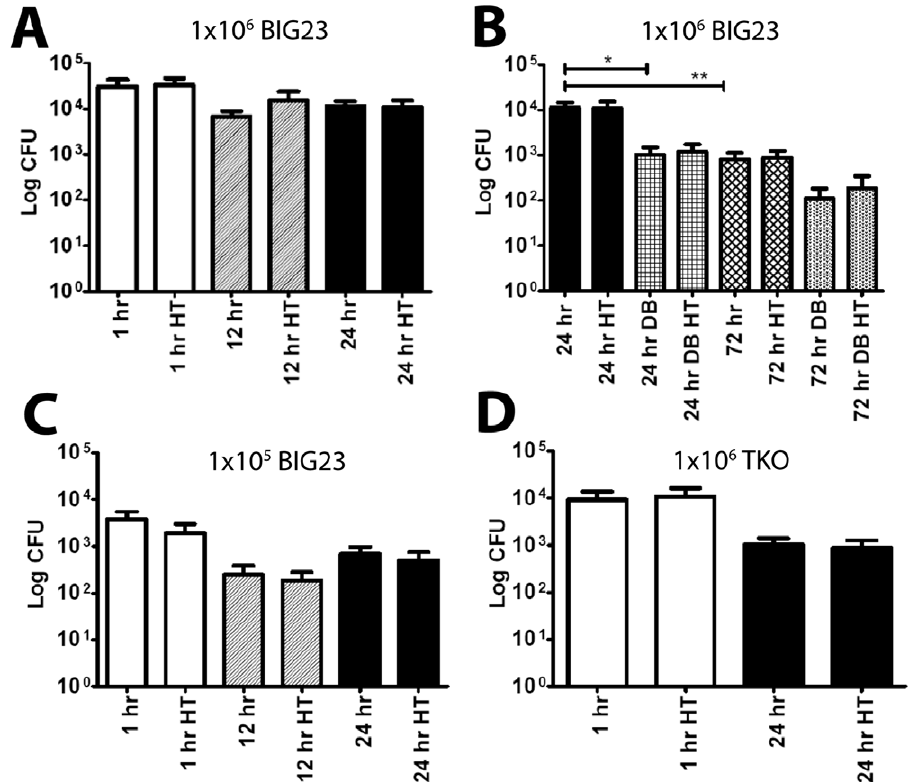
Figure 2. B.anthracis spores are found in the draining cervical lymph node early in infection. (A–C) BIG23 spores were inoculated subcutaneously into the left ear of 4–12 week old A/J mice. At the indicated times cervical draining lymph nodes were removed and CFU derived from vegetative cells verses spores were differentiated by quantifying samples with and without heat treatment (HT). Bars denote the mean and error bars represent the standard error of the mean. Significance was determined using Student’s T-est. (A) Quantification of bacteria within the draining lymph node at 1, 12, and 24 hours post-infection (p.i.) from mice inoculated with 1 6 10 6 spores. There were no significant differences with or without heat treatment or between different time points using a total of six mice in three independent experiments. (B) Quantification of bacteria within the draining lymph node at 24 and 72 hours p.i. with and without debridement (DB) performed at 12 hours after inoculation with 1 6 10 6 spores. Significant differences were observed in a total of six mice in three independent experiments between 24 hr and 24 hr DB (*, p=0.0144) and 24 hr and 72 hr (**, p=0.0066). There were no significant differences between heated and unheated samples at either time with or without debridement. (C) Bacteria within the lymph node were quantified similarly to A at 1, 12, and 24 hours p.i., but with an inoculation of 1 6 10 5 spores in a total of six mice in three independent experiments. There were no significant differences with or without heat treatment. (D) Bacteria within the lymph nodes were quantified similarly to A at 1 and 24 hours p.i., but instead, 1 6 10 6 spores of the mutant strain that produced no exotoxins (TKO) were inoculated in a total of six mice in three independent experiments. There were no significant differences with or without heat treatment.